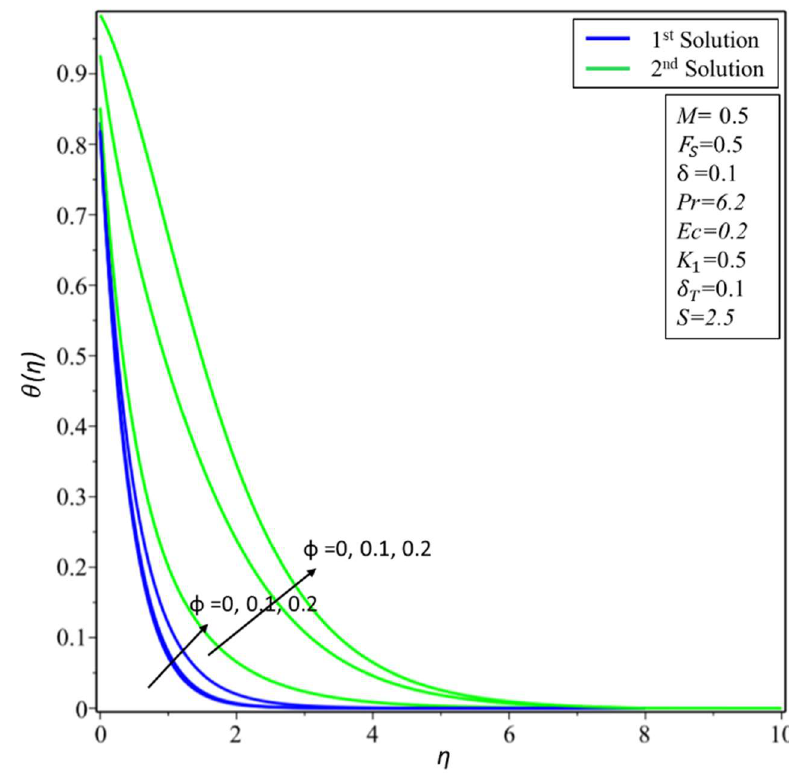
Figure 3. Changes of 𝜃(𝜂) for ∅ .